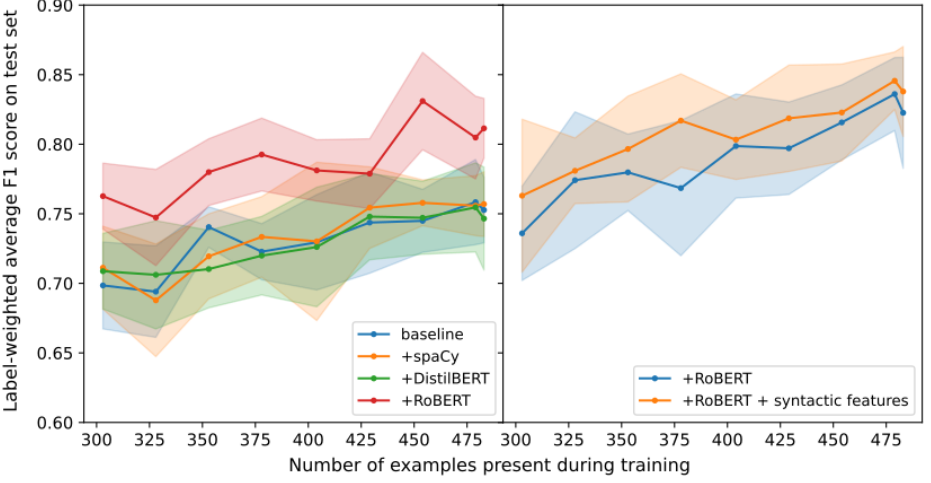
Figure 9. Comparison of NLU pipeline